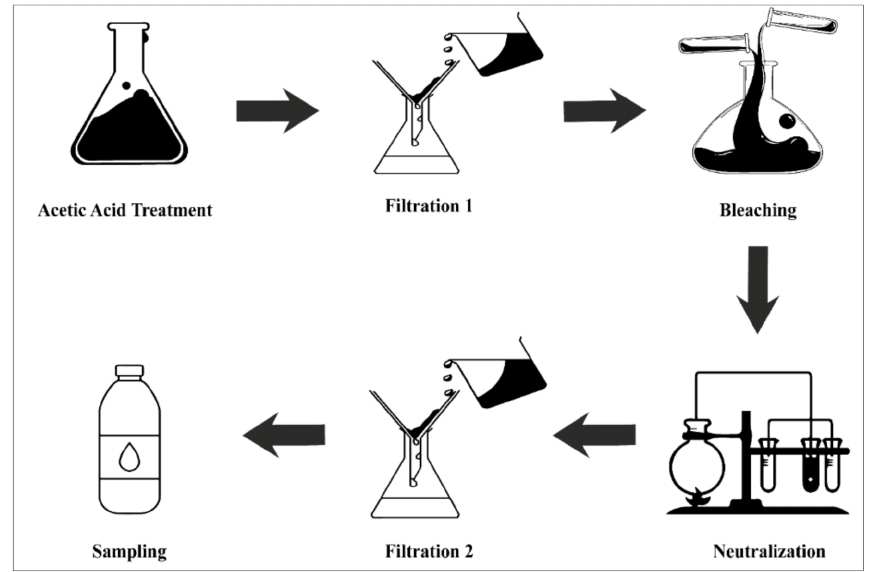
Figure 3. Regeneration